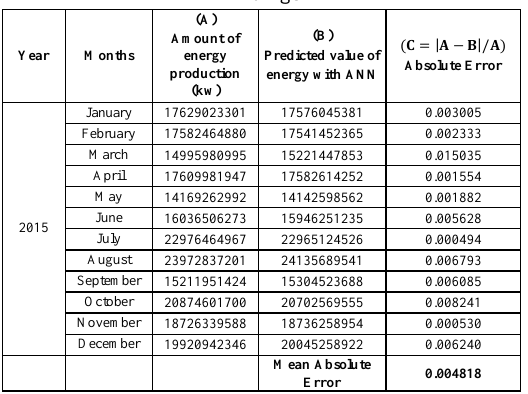
Table 1. Comparing the energy production values and ANN